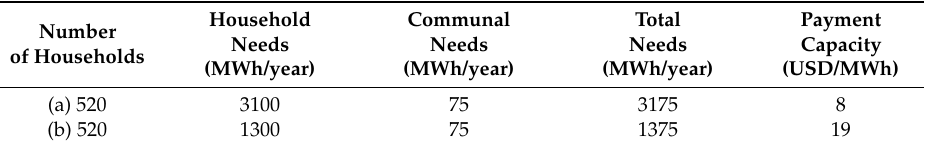
Table 3. Total energy needs and payment capacity of Chua Village assuming (a) 1100 (results